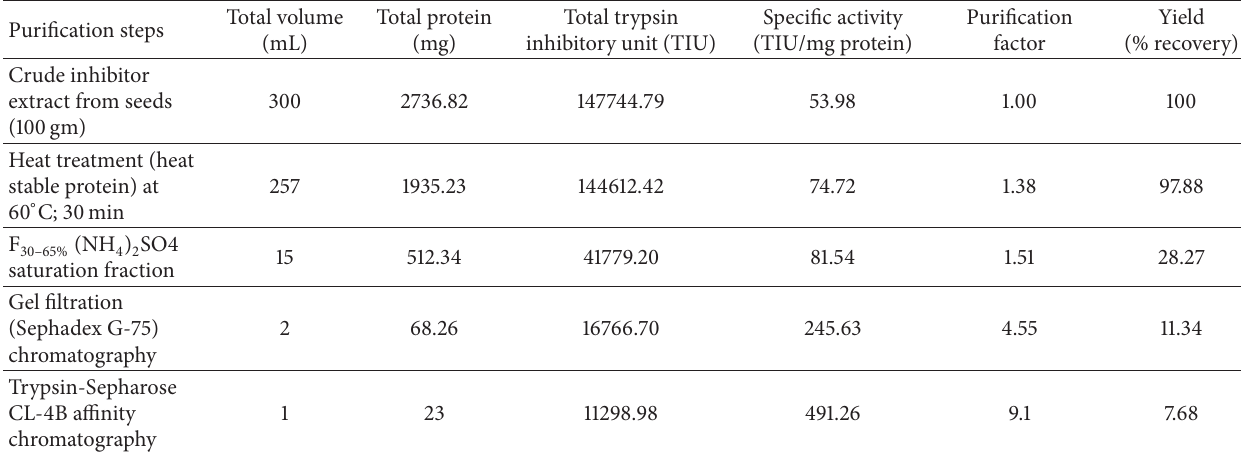
Table 1: Purification and percent recovery of BmPI from B. monosperma seeds.